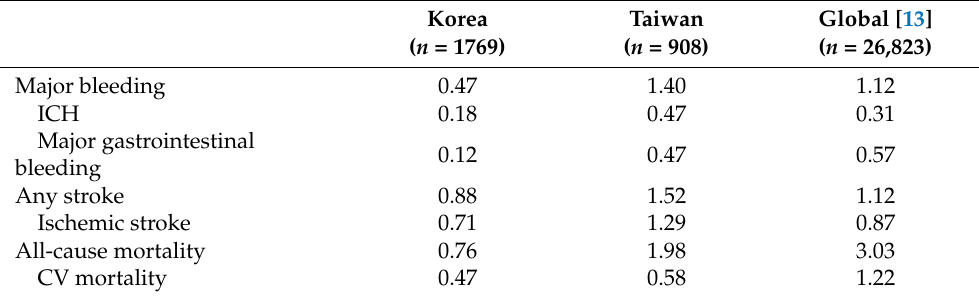
Table 3. Comparison of ETNA-AF Korea/Taiwan and ETNA-AF global one-year clinical events.